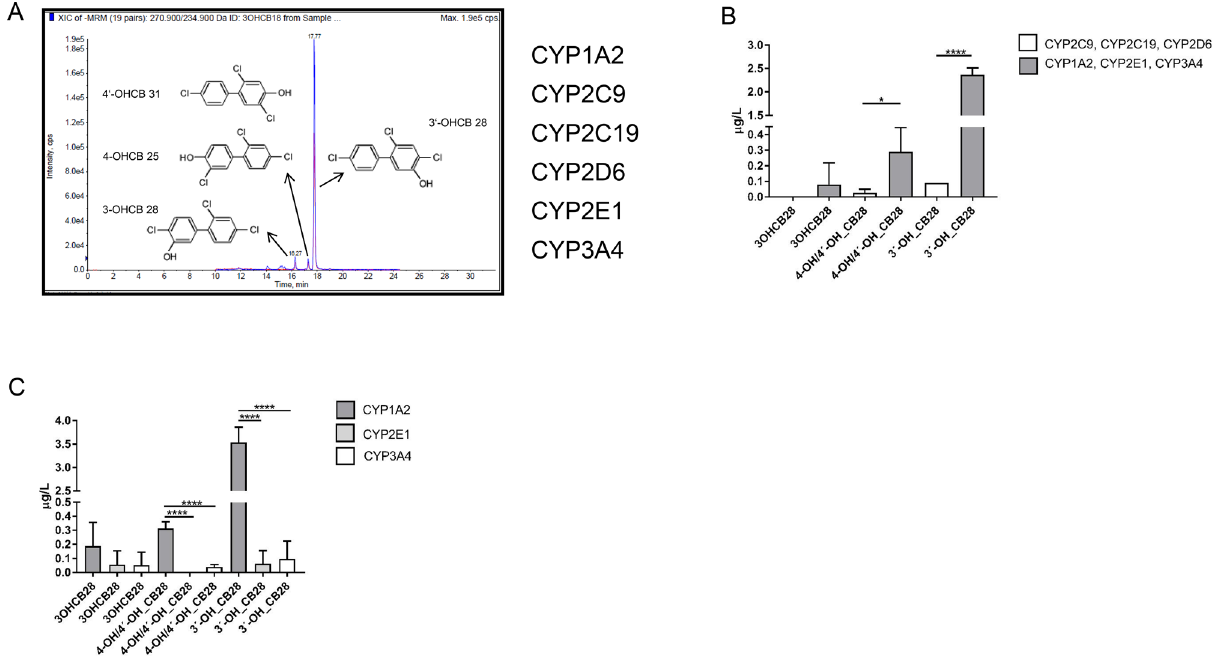
Figure 3. Metabolic activation of PCB 28 in the presence of a recombinant liver-like cytochrome P450 cocktail. ( A ) LC–MS/MS chromatogram of 3-OH-CB28, 3´-OH-CB28 and 4-OH/4´-OH-CB28 after incubation of PCB 28 with recombinantly expressed CYP1A2, CYP2C9, CYP2C19, CYP2D6, CYP2E1 and CYP3A4 (rhCYP cocktail) for 1 h. ( B ) Amounts of 3-OHCB 28, 3´-OHCB 28 and 4-OH/4´-OHCB 28 detected after incubation of PCB 28 with different constituents of the rhCYP cocktail. ( C ) Amounts of OH-CB28 metabolites detected after single incubation of PCB 28 either with CYP1A2, CYP2E1 or CYP3A4. Mean ± SD of 3 technical replicates are shown. ( B , C ) Results between groups of CYPs were compared by ANOVA and adjusted by posthoc Tukey-test for multiple measures. Statistical differences are as indicated (*p ≤ 0.05; ****p ≤